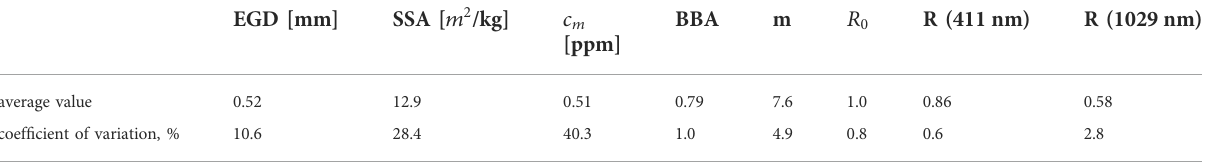
TABLE 4 Average values of retrieved parameters and re fl ectance at R (411 nm) and R (1029 nm) for the focus